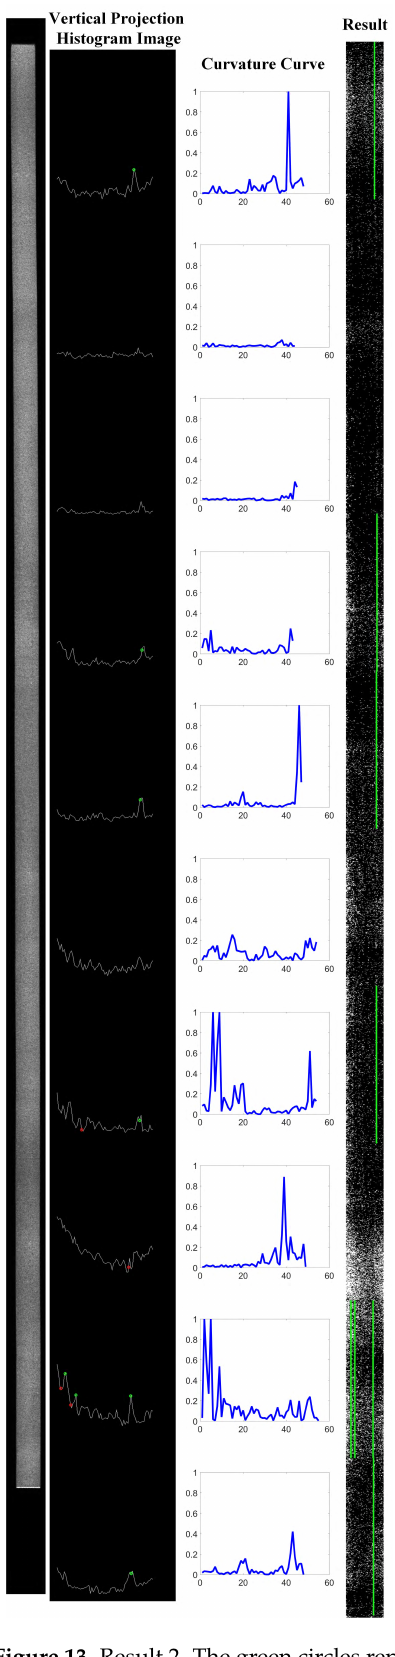
Figure 13 Figure 13. Result 2. The green circles represent local maximums, red circles represent local valleys, and the green lines represent the detected